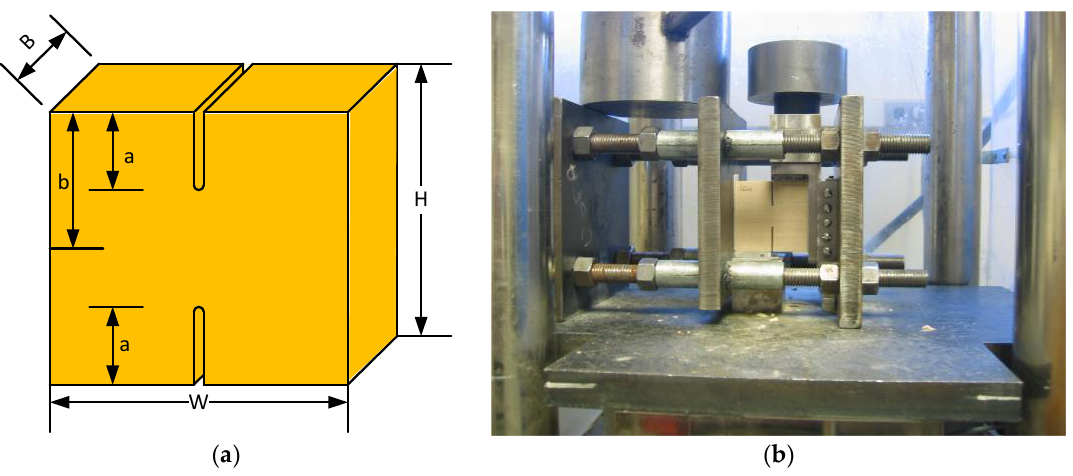
Figure 5. Single-shear test: ( a ) specimen geometry; ( b ) test set-up.